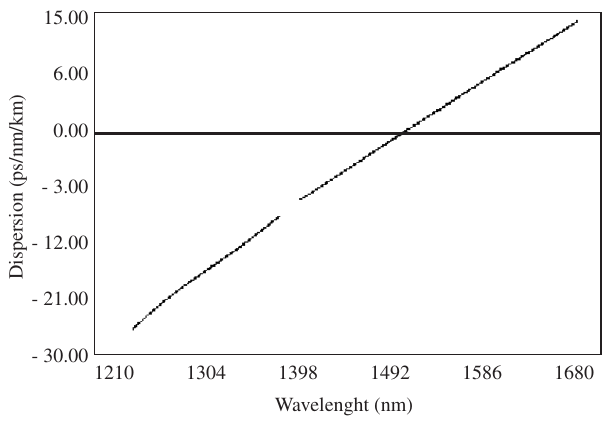
Figure 2. Dispersion as a function of wavelength for single mode fiber. The experimental setup measures the dispersion in two different wavelength bands (window); i.e. 1230 to 1380 nm and 1420 to 1600 nm